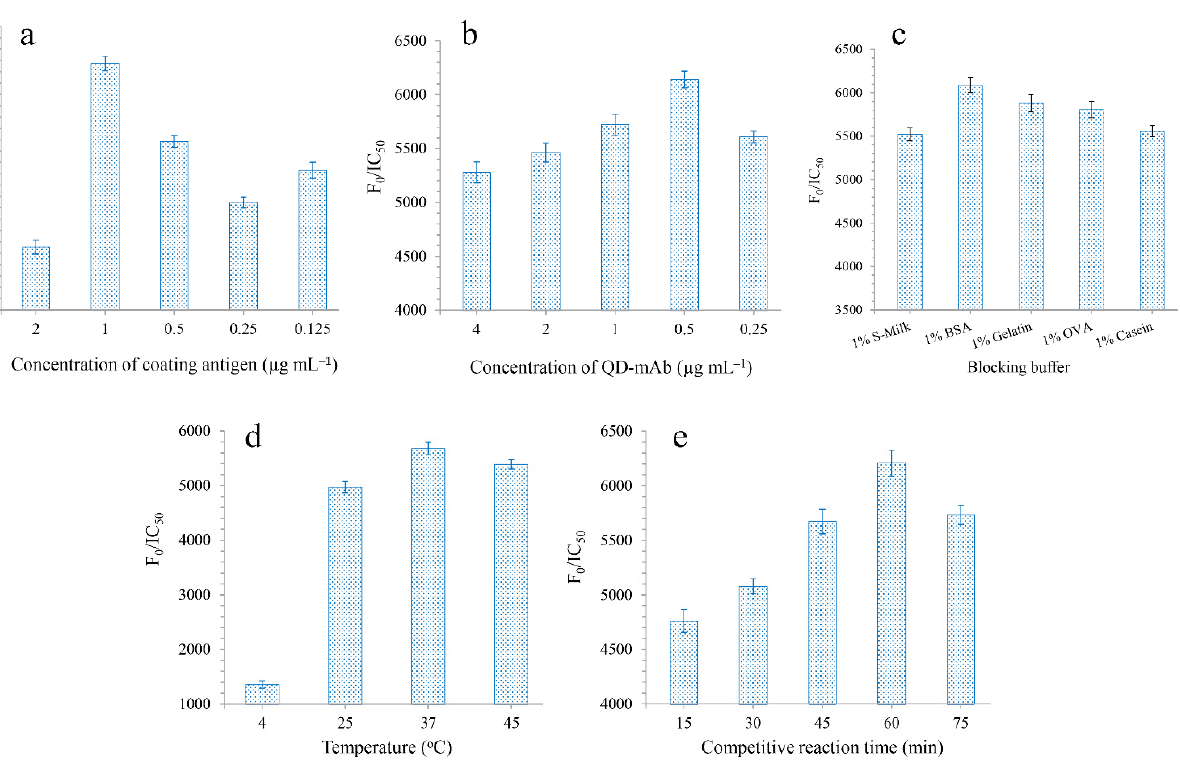
Figure 2. ( a ) Effect of DOX-PABA-OVA concentrations (2, 1, 0.5, 0.25 and 0.125 μ g mL –1 ) on F 0 /IC 50 . ( b ) The ratio of F 0 /IC 50 with different blocking buffer (1% S-Milk, 1% BSA, 1% Gelatin, 1% OVA and 1% Casein). ( c ) The ratio of F 0 /IC 50 under different concentrations of QDs-labeled mAb (4, 2, 1, 0.5 and 0.25 μ g mL –1 ). ( d ) The ratio of F 0 /IC 50 under different incubation temperatures: 4 °C, 25 °C, 37 °C and 45 °C, respectively. ( e ) The ratio of F 0 /IC 50 under different competitive reaction time: 15, 30, 45, 60 and 75 min, respectively. The error bars represent the standard deviation of three measur- ments.